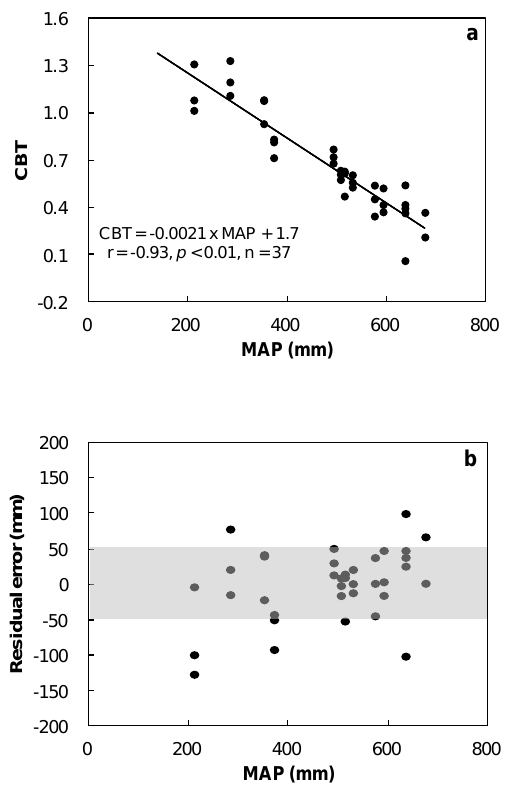
Figure 8. Comparison of variations in CBT-inferred MAP, bGDGT- derived temperature and magnetic susceptibility (MS) records of three LPS sections (a, b, c) with speleothem-based EASM record (Wang et al., 2001, 2008) and local insolation (Huybers, 2006) (d) . The three LPS sections are from Yuanbao ( a , Jia et al., 2013), Lan- tian ( b , Gao et al., 2012) and Mangshan ( c , Peterse et al., 2014), respectively. The grey shade, light grey shade, blue dashed line, and orange dashed line indicate MIS 1, MIS 3, onset of precipitation enhancement (OP), and onset of deglacial warming (OM), respec-